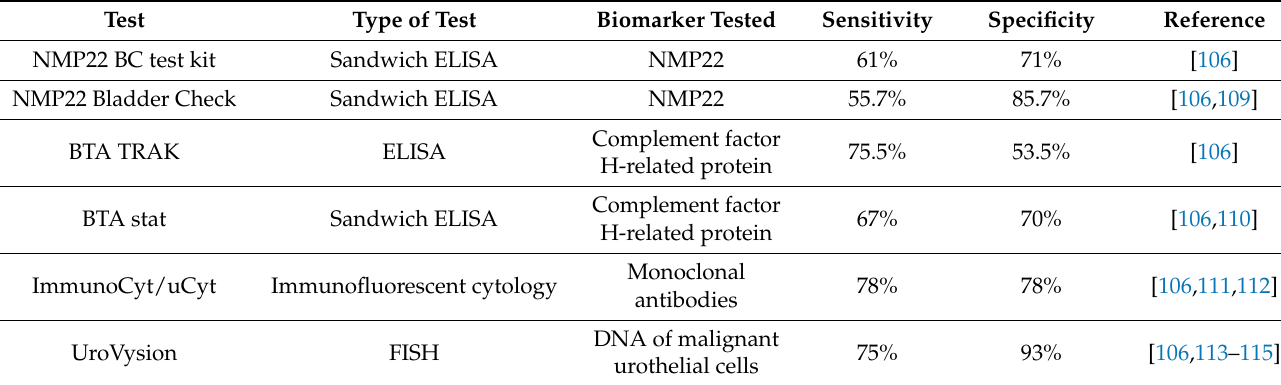
Table 2. FDA Approved Urine Biomarker Tests for Bladder